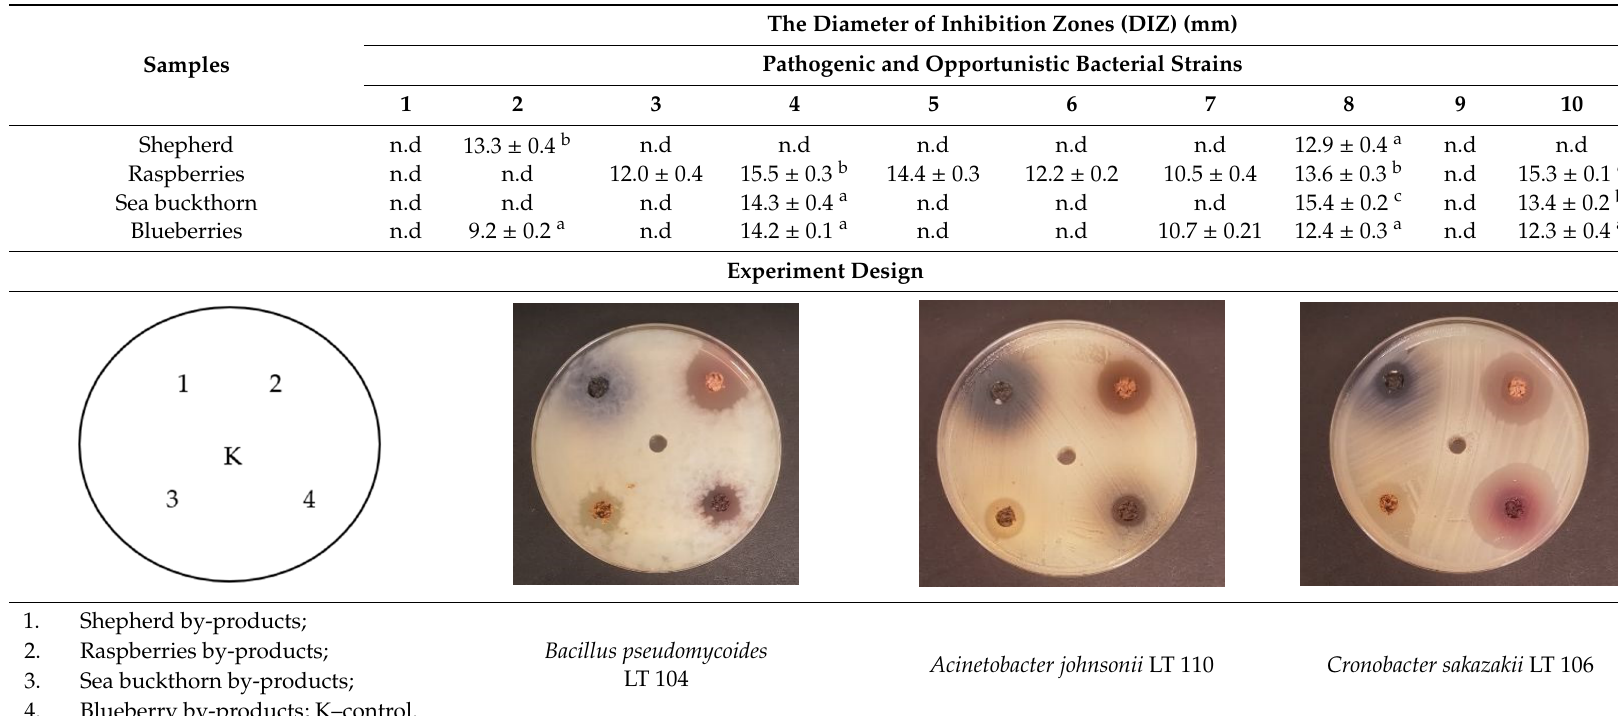
Table 5. Antimicrobial properties of the fruit/berry by-products.